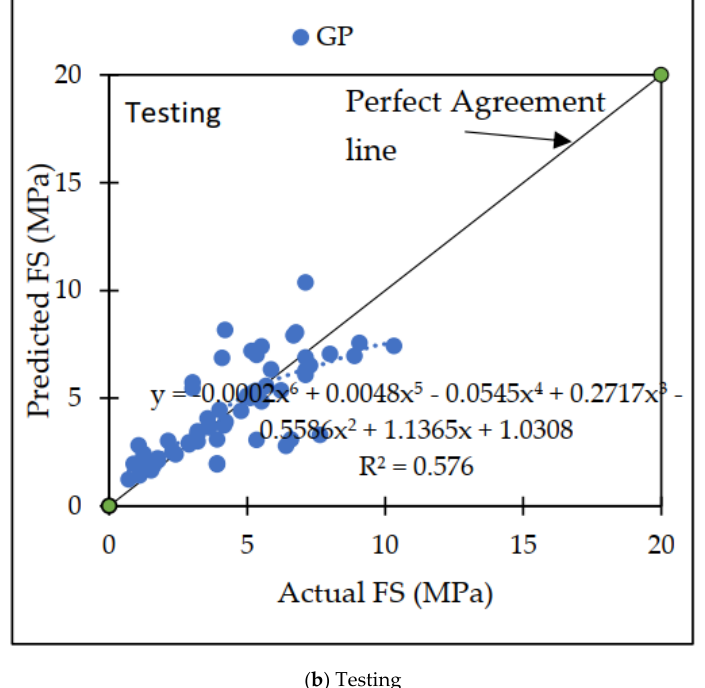
Table 9. Performances of SVM, GP, and ANFIS. Figure 8. The scatter graph displays the observed and GP-predicted FS. Figure 8. The scatter graph displays the observed and GP-predicted FS.